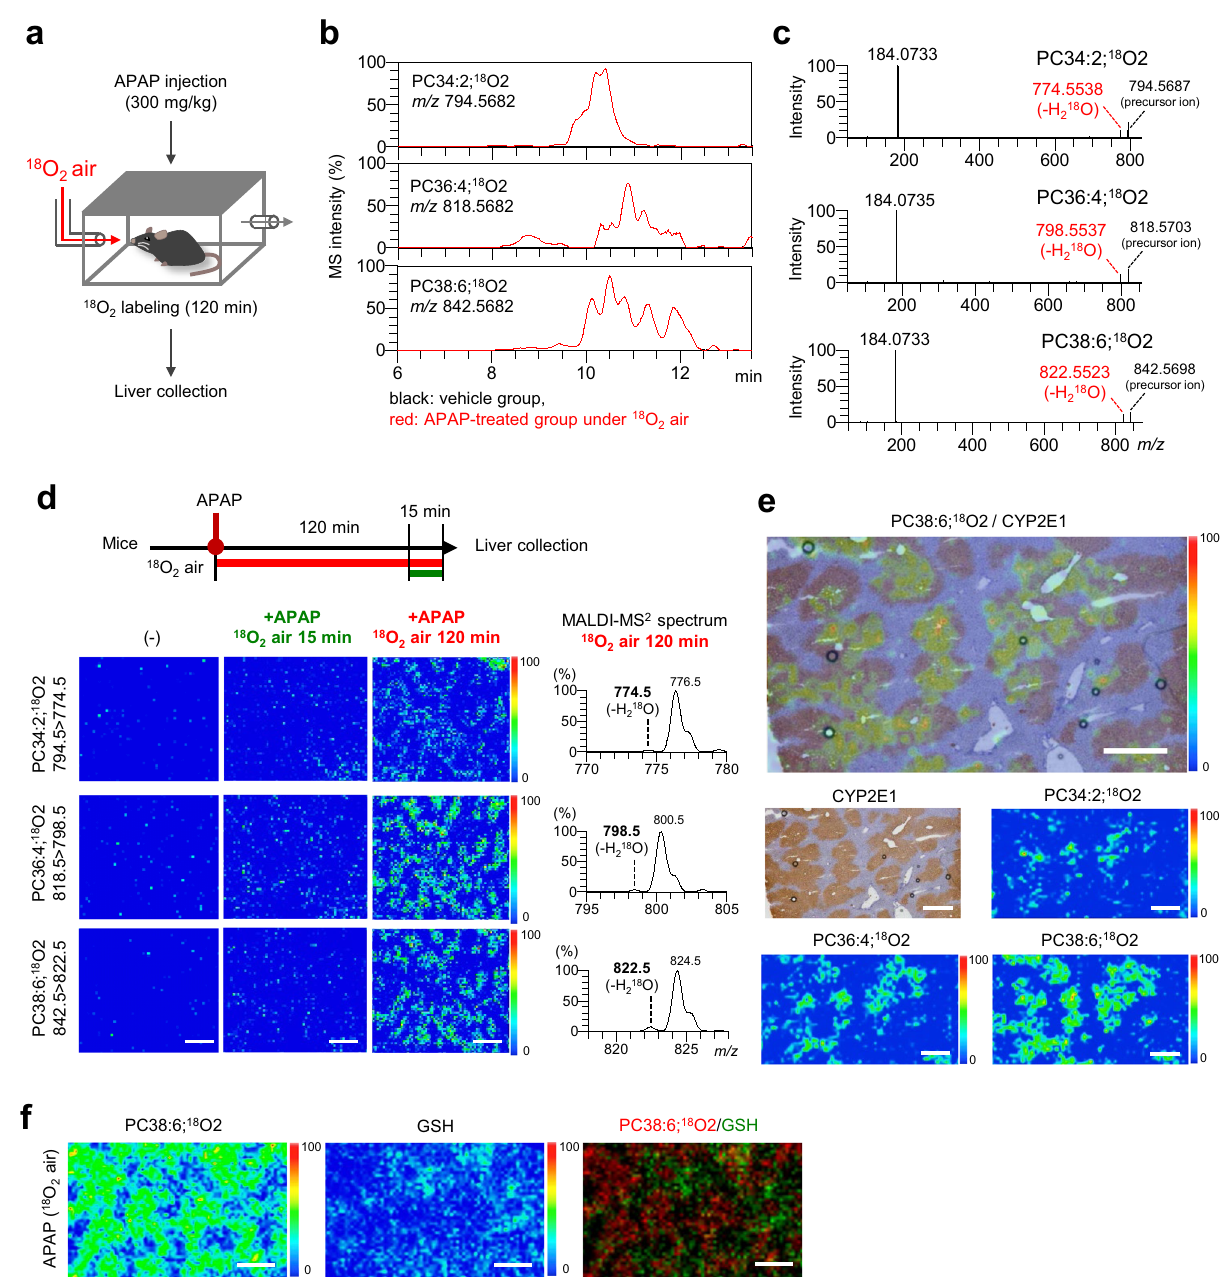
Fig. 5 Visualization of endogenous oxPCs by a combination of MALDI-MS/MS/MSI and 18 O 2 labeling. a Experimental design for the 18 O 2 labeling of endogenous oxPCs in APAP-treated mice. b Extracted ion chromatograms for ions with m/z 794.5682, 818.5682, and 842.5682 corresponding to PC34:2; 18 O2, PC36:4; 18 O2, and PC38:6; 18 O2, respectively. Black = vehicle-treated group, red = APAP-treated group (120min in 18 O 2 air). c HRMS/MS spectra of parent ions with m/z 794.5682, 818.5682, and 842.5682 were observed for the APAP-treated group (120min in 18 O 2 air). d MALDI-MS/MS/MSI results for PC34:2; 18 O2 (794.5 → 774.5), PC36:4; 18 O2 (818.5 → 798.5), and PC38:6; 18 O2 (842.5 → 822.5) in the mouse liver sections. Left panel = vehicle-treated group, middle panel = APAP-treated group (mice were incubated in normal air for 105min after APAP treatment and then incubated in 18 O 2 air for 15min), and right panel = APAP-treated group (120min in 18 O 2 air). Scale bar = 1mm. MALDI-MS/MS spectra of 18 O-labeled oxPCs extracted from the liver of APAP-treated mice (120min in 18 O 2 air). e Distribution of 18 O-labeled oxPCs and CYP2E1 expression. Hepatic CYP2E1 expression was analyzed by immunohistochemical staining. Scale bar = 500 µ m. f MALDI-MS/MS/MSI results for PC38:6; 18 O2 (842.5 → 822.5) and GSH (305.3 → 206.2). Scale bar = 1mm. In the pseudocolor scale in d – f , the maximum intensity of the detected signal is set to “ 100 ” and the intensity 0 is set to “ 0 ”